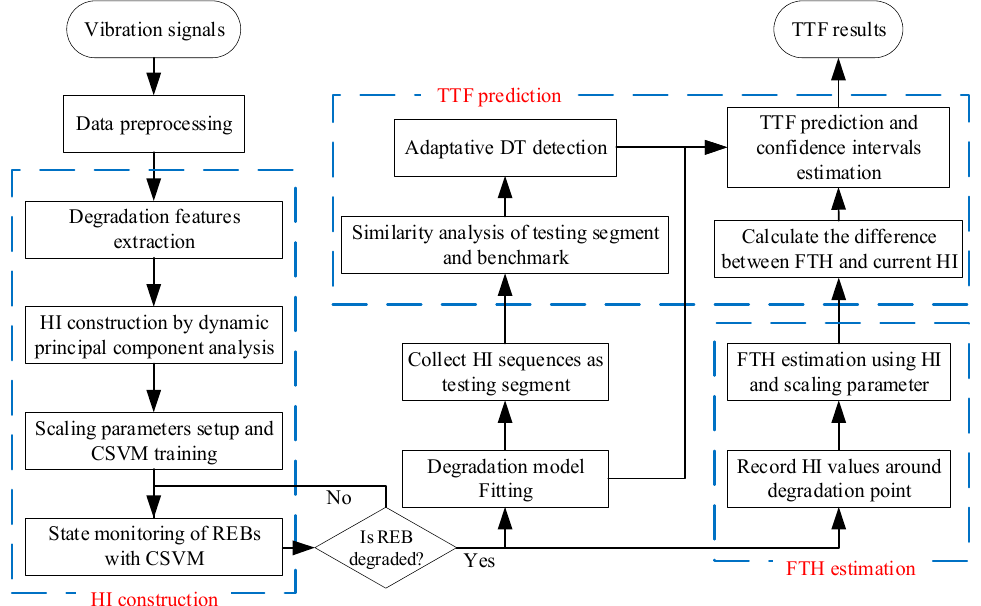
Figure 1. System scheme of time-to-failure prediction approach of bearings.